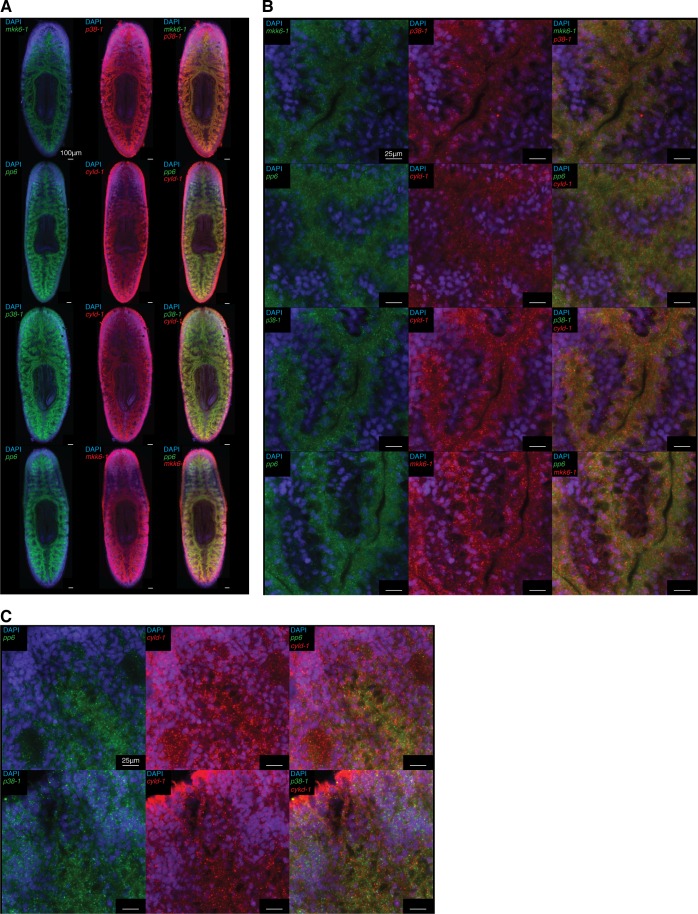
Co-expression of TAK1/MKK/p38 pathway components.Fluorescent double WISH of mkk6-1/p38-1, pp6/cyld-1, p38-1/cyld-1, and pp6/mkk6-1 in (A) whole worms and (B) posterior gut tissue (n = 6–8 worms).(C) Fluorescent double WISH of pp6/cyld-1 and p38-1/cyld-1 in the anterior mesenchyme (n = 6–8 worms). Identical settings used for posterior gut and anterior mesenchyme for comparison of cells surrounding the gut. Negative controls treated identically but lacking DIG and DNP labeled probes were used to determine non-specific background staining.